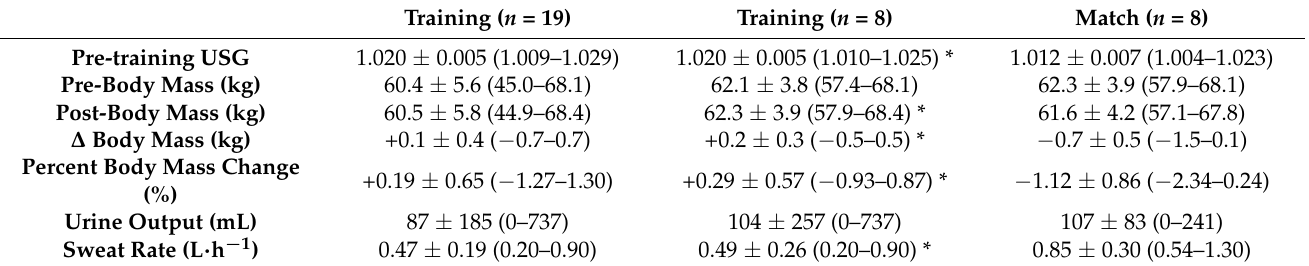
Table 2. Sweat test variables recorded before and during training and match (mean ± SD (range)). Training ( n = 8) and match ( n = 8) only includes data of players that completed both the full training session and match. * indicates training significantly different to match ( p <